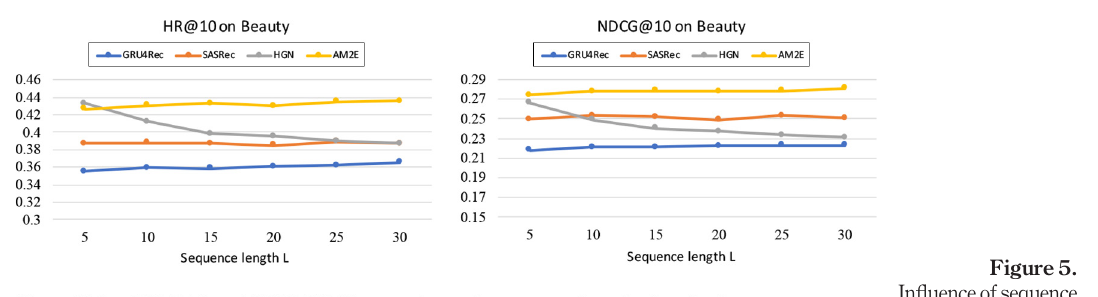
Figure 5. In fl uence of sequence